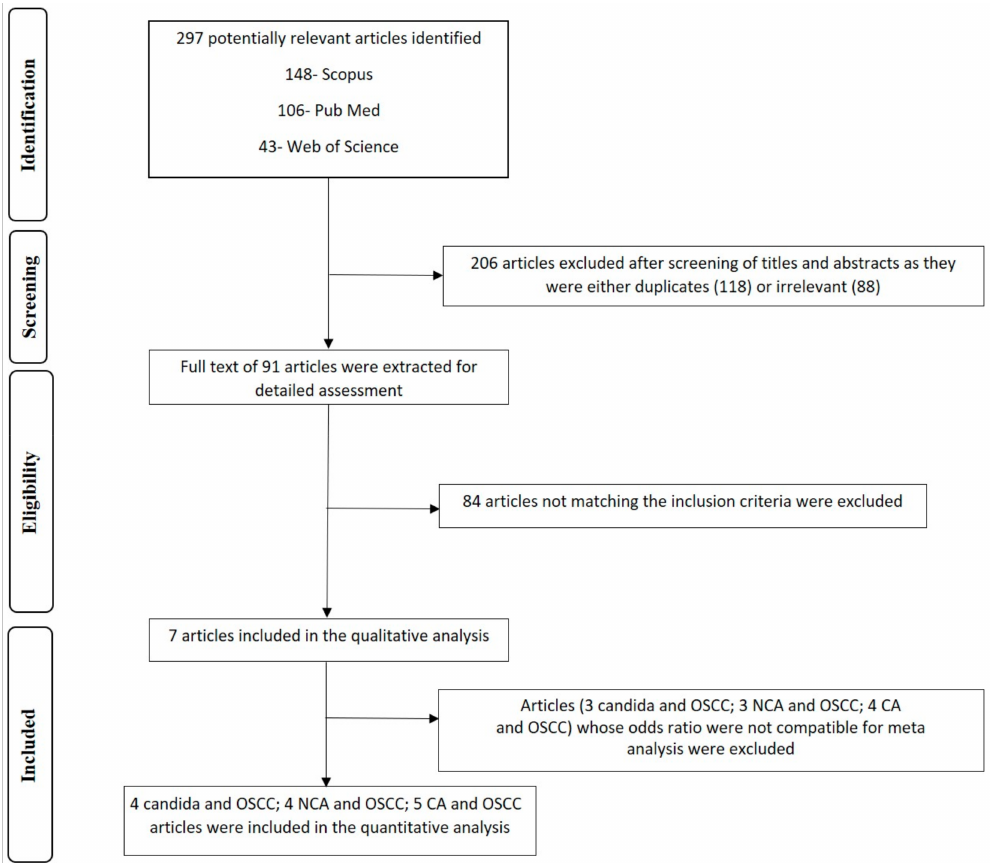
Figure 1. Summary of the search strategy